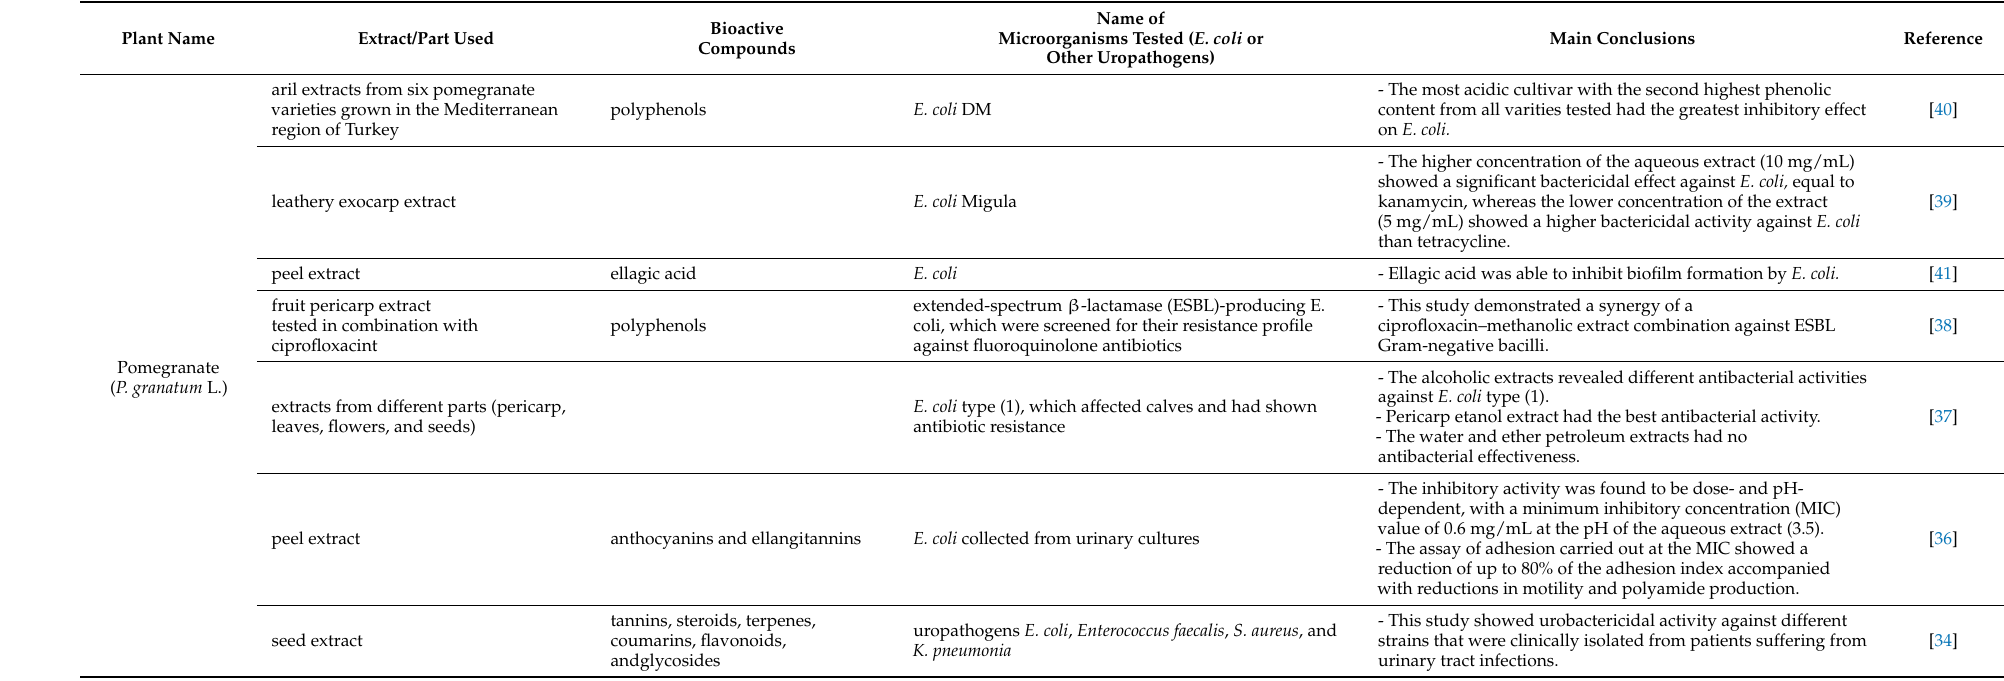
Table 1. Anti-uropathogenic activities of extracts from pomegranate ( P. granatum L.), black chockeberry ( A. melanocarpa Michx.), and cornelian cherry ( C. mas